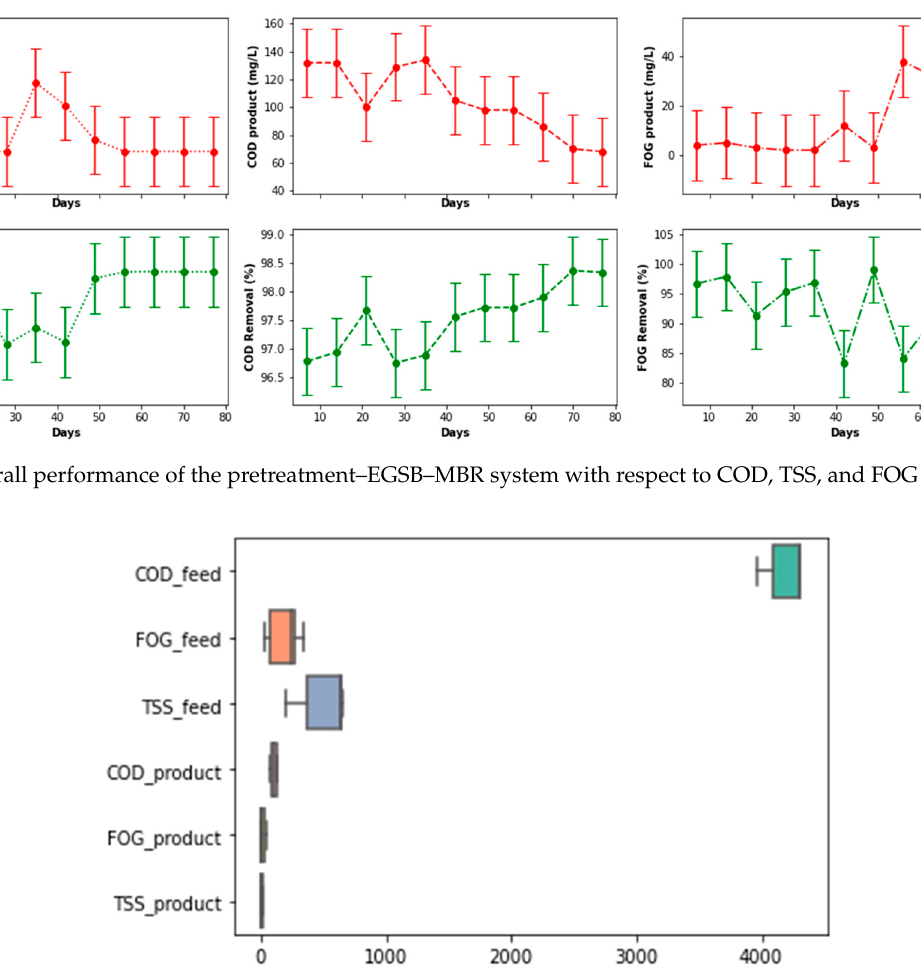
Figure 21. 3D plot of the overall performance (COD VS FOG) Figure 22. 3D plot of the overall performance (COD VS TSS) 3.5. MBR Final Effluent Quality Compared to the Wastewater Discharge Standards Table 1 provides a summary of the results obtained from the MBR outlet compared to wastewater discharge standards from several regulatory bodies, i.e., CoCT, Department of Water Affairs (DWA) 2010, and South African National Standards (SANS) 241:2015 for